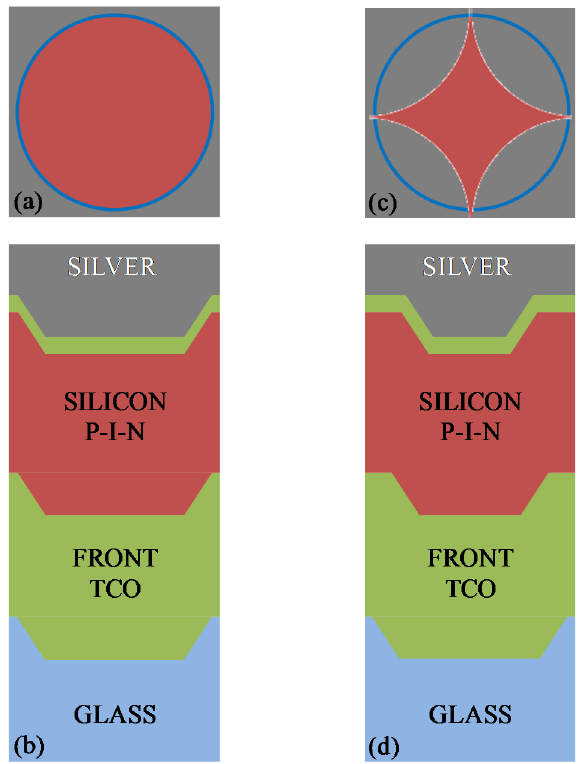
Figure 8. Schematics of the implemented numerical models: ( a ) top view and ( b ) cross-section of the first model, where the deposition effects are neglected; ( c ) top view and ( d ) cross-section of the second model, where the growth effects are considered as observed by AFM